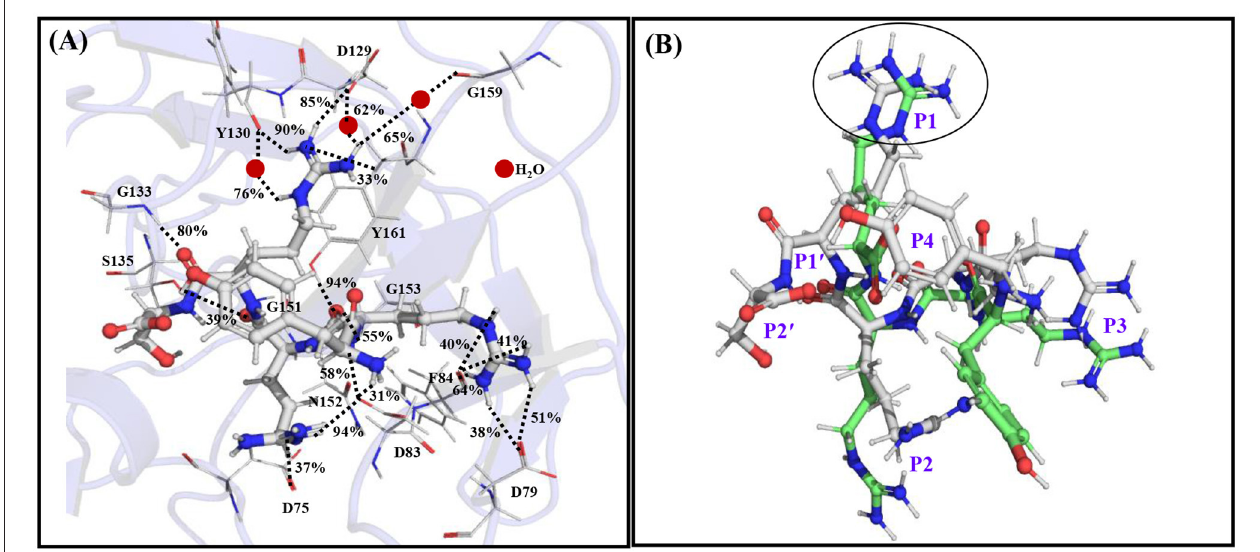
FIGURE 3 | (A) The average simulated structure of the YRRRS-protease complex. The different interactions between the peptide and protease are shown by dotted lines and the percentage occupations of these interactions evolved throughout the simulation are also mentioned. (B) The superimposition of the average simulated structure of the YRRRS-protease [ (C) atoms are shown in white] onto the average simulated structure of the YRRR-protease [ (C) atoms are shown in green] complex (protease structures are not shown). The P2’-P4 residues of the inhibitors are labeled in (B)